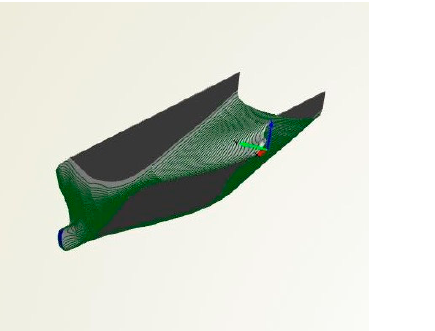
Figure 2. The geometry of KRISO containership as derived by CAESES software.